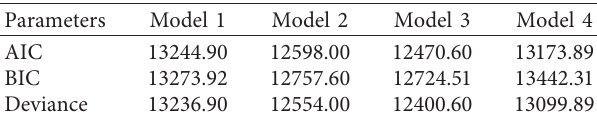
Table 5: Goodness-of-fit assessment for both single-level logistic and multilevel logistic models using AIC, BIC, and